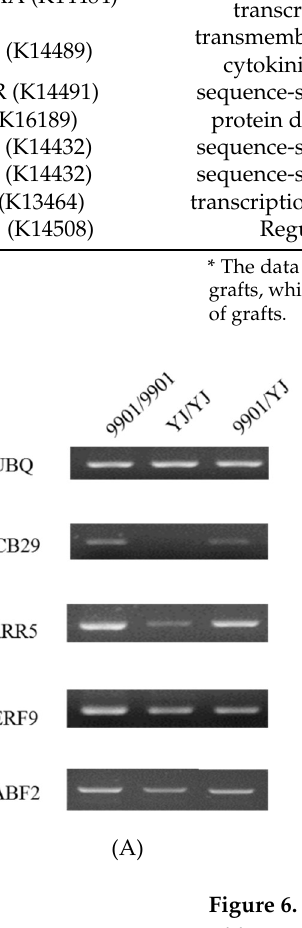
* The data outside the parentheses means the expression abundance of 9901 homologous gene in rootstock of grafts, while the data inside the parentheses means the expression abundance of YJ homologous gene in rootstock of grafts.